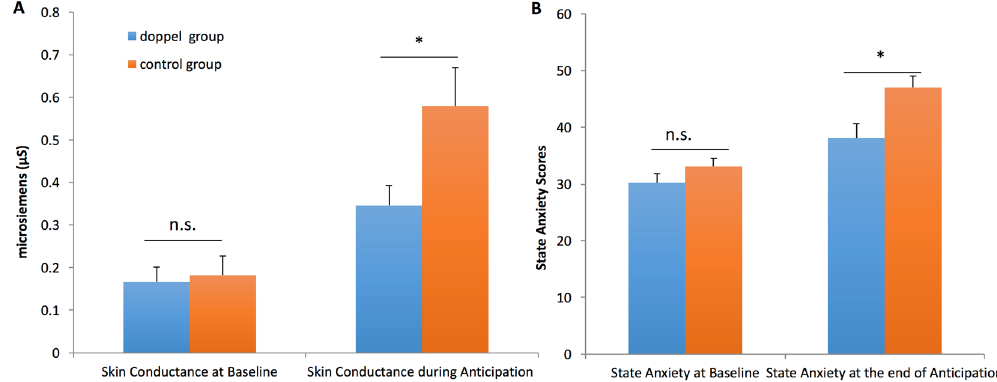
Figure 2. Average Skin Conductance levels across conditions and groups ( A ), and average state anxiety scores ( B ). Error bars indicate S.E.M.